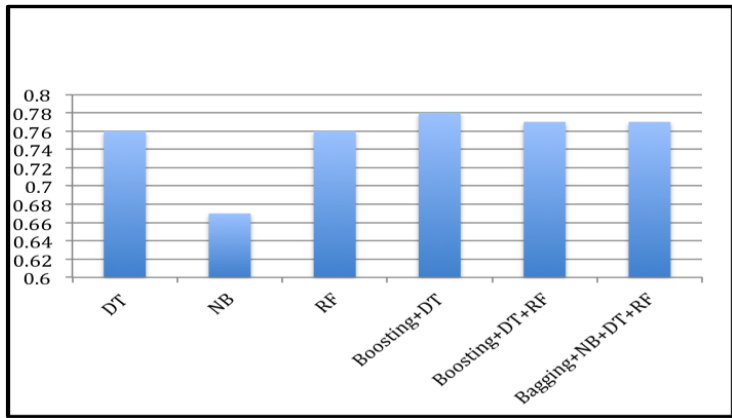
Figure 17. The F-measure of DM techniques and ensemble